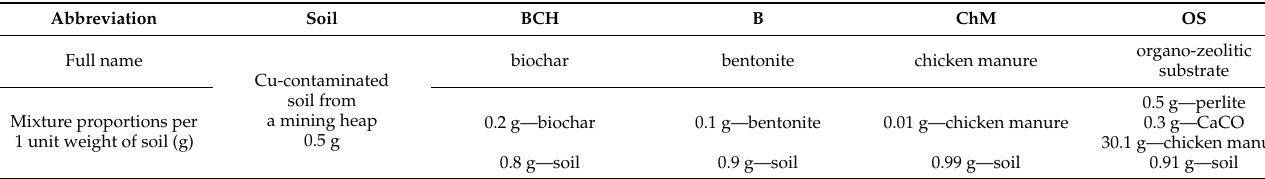
Table 3. Soil modifications used in the